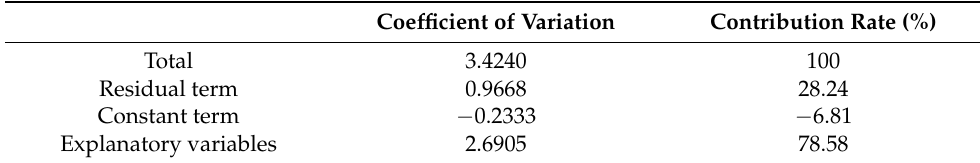
Table 3. Contribution of residual, constant, and explanatory variables to poverty